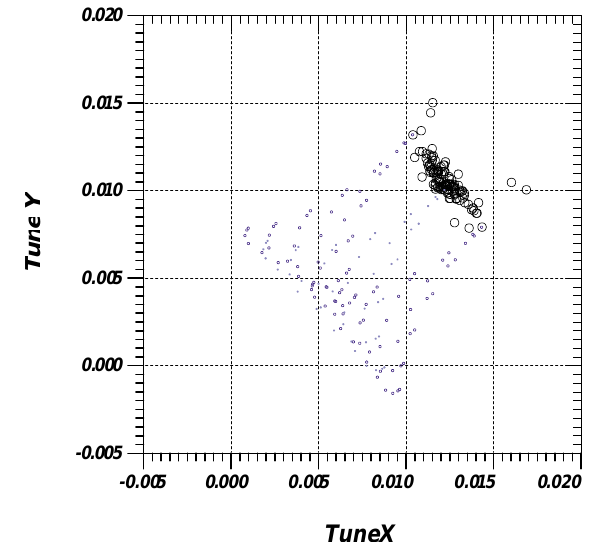
FIG. 1. (Color) Tune spread in the antiproton beam for TEV33. Large circles are for tunes of core particles in 121 antiproton bunches. Small circles are tunes of nonzero betatron amplitude particles in some bunches.